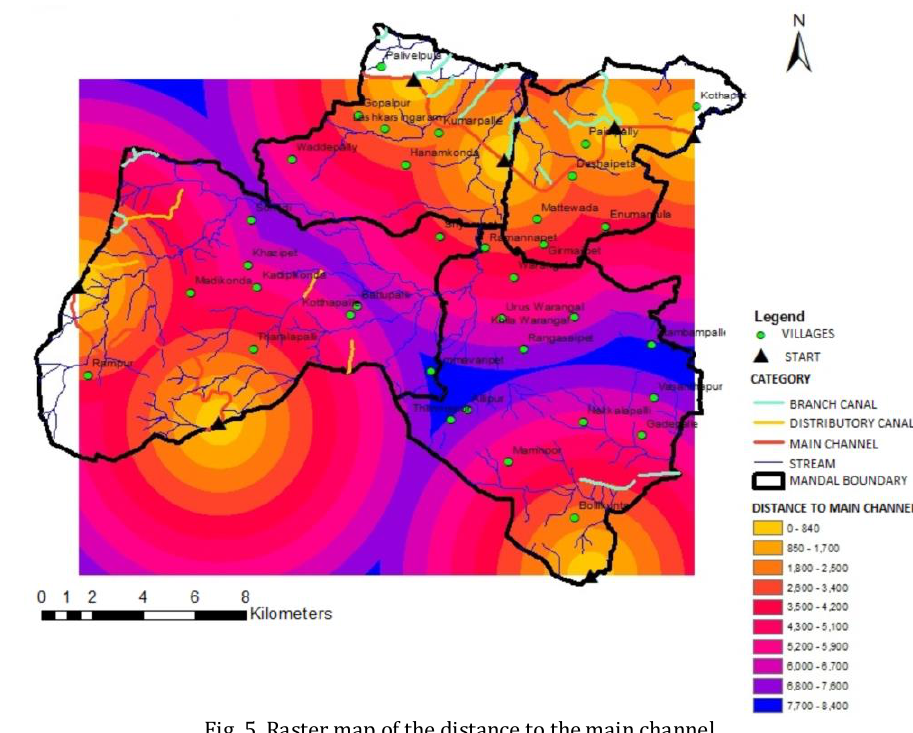
Fig. 5. Raster map of the distance to the main channel